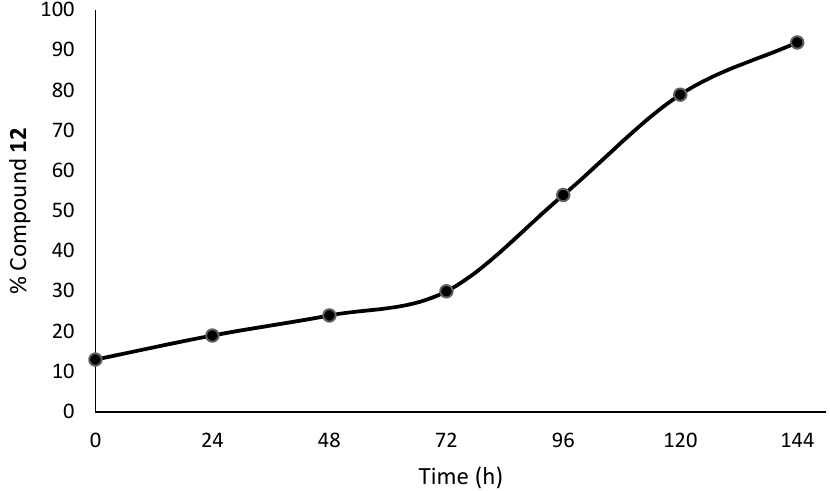
Figure 6. Proportion of 12 and time by 1 H-NMR. Percentage of 12 was calculated relative to the signals of tert-butyl groups of 11 and 12 .